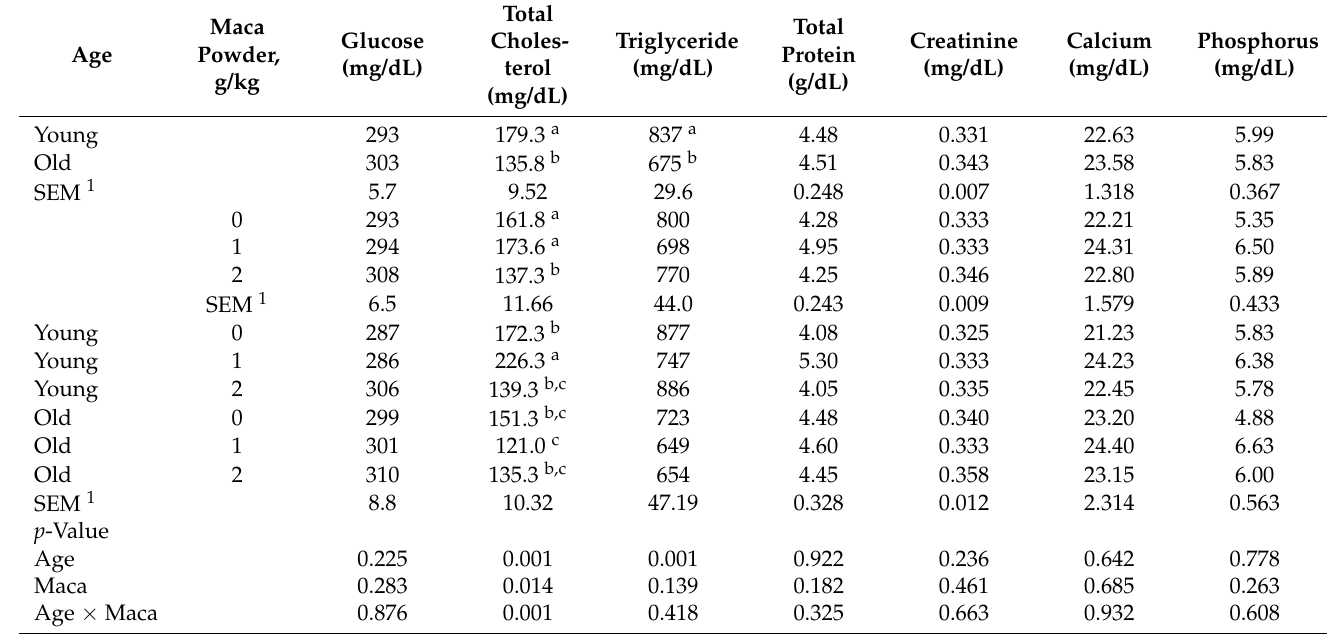
Table 4. Effects of Maca powder supplementation in diets of laying quails at different ages on serum biochemical